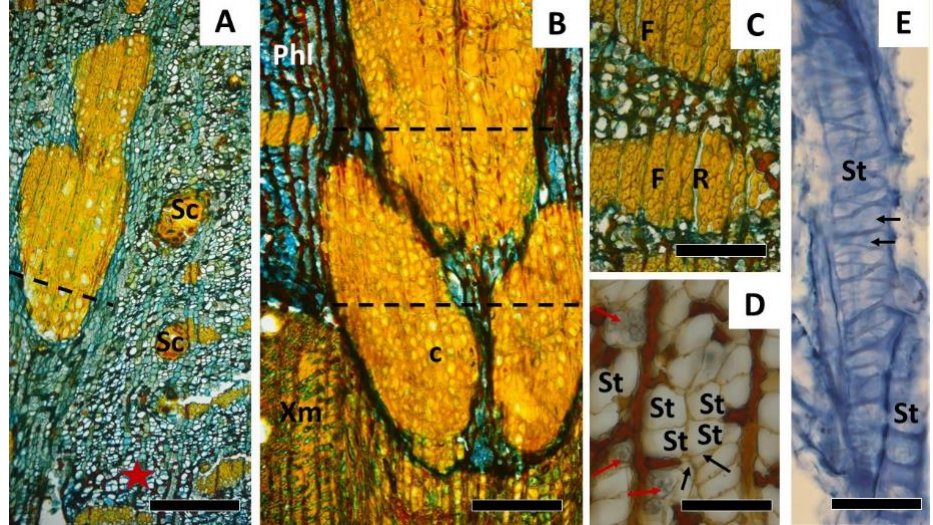
Figure 3. Transverse section of the secondary phloem of Quercus rotundifolia . ( A ) Nonconducting and conducting phloem (asterisk), large rays (---) with sclerified ray parenchyma cells; spherical groups of sclereids (Sc); ( B ) the broad rays (---) of the phloem (Phl) protrude into the xylem (Xm); crystals (c); ( C ) fibers (F) in tangential groups transversed by the thin rays (R); ( D ) sieve tube elements (St) with companion cells (black arrows); druses (red arrows); ( E ) sieve tube elements (St) with many lateral sieve areas (arrows). Scale bar: A = 200 μm; B = 200 μm; C = 130 μm; D = 50 μm; E = 50 μm.